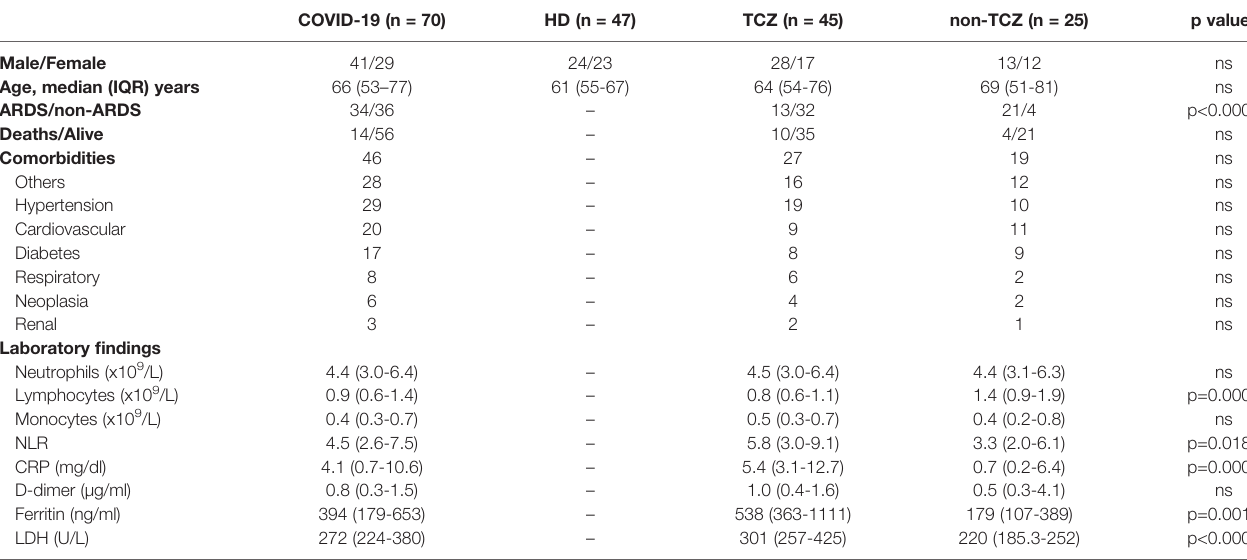
TABLE 1 | Demographic and clinical features of study population on hospital